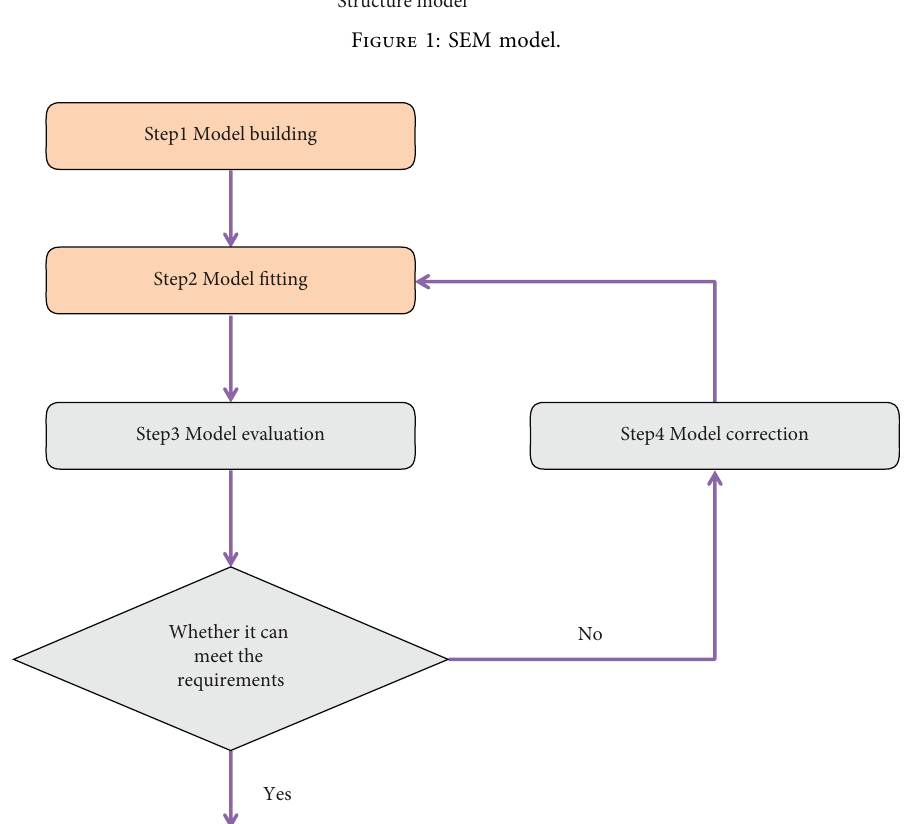
Figure 1: SEM model.